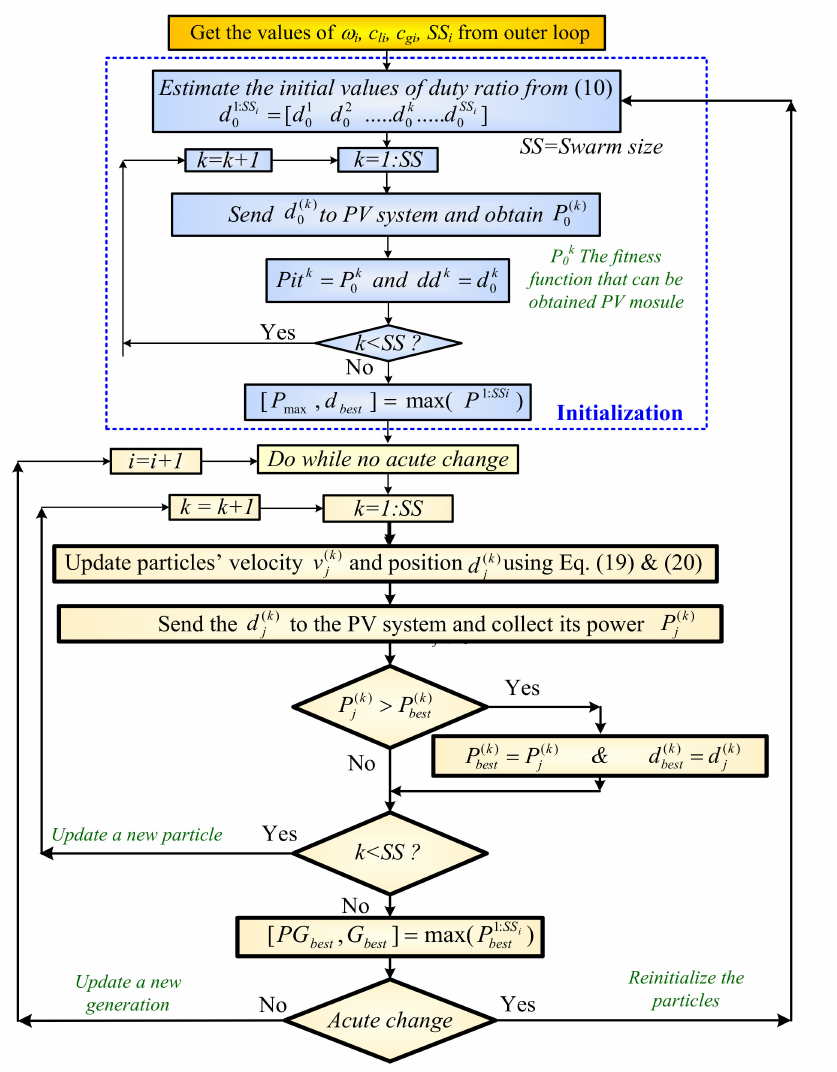
Figure 7. Flow chart of MPPT of PV system using the